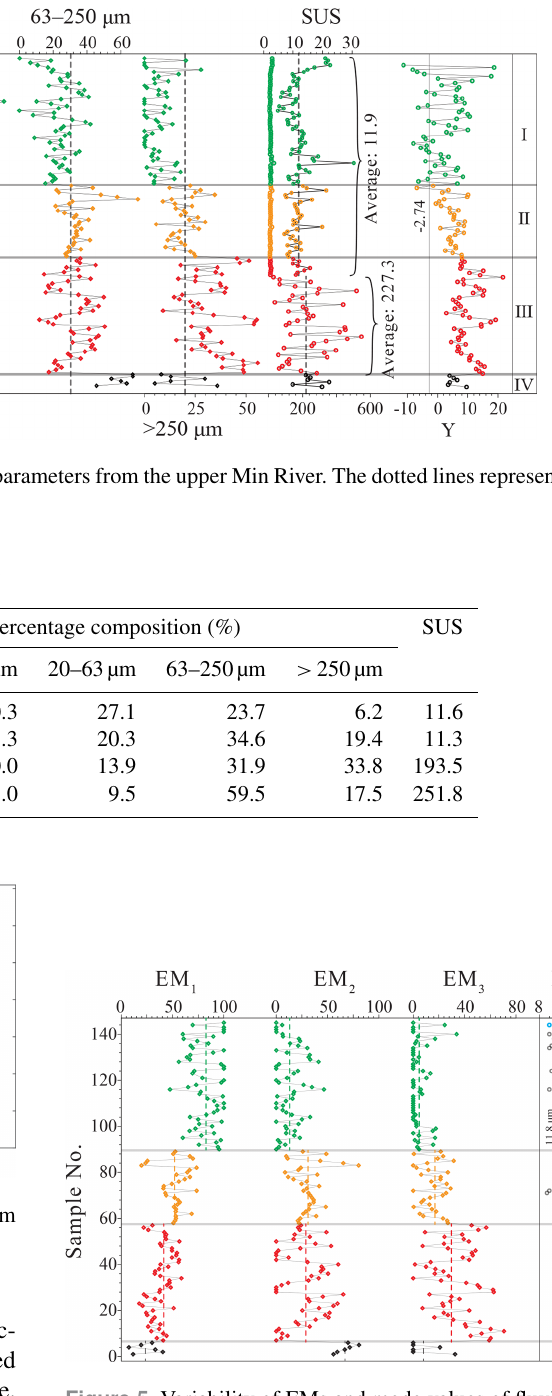
Figure 5. Variability of EMs and mode values of fluvial sediments from the upper Min River. The peak values (mode values) with > 1% fractional abundance of the grain-size frequency distributions were extracted after consideration of a 1% instrumental error. Blue and gray circles represent the main and secondary peak modal val- ues, respectively. The dotted lines represent the average